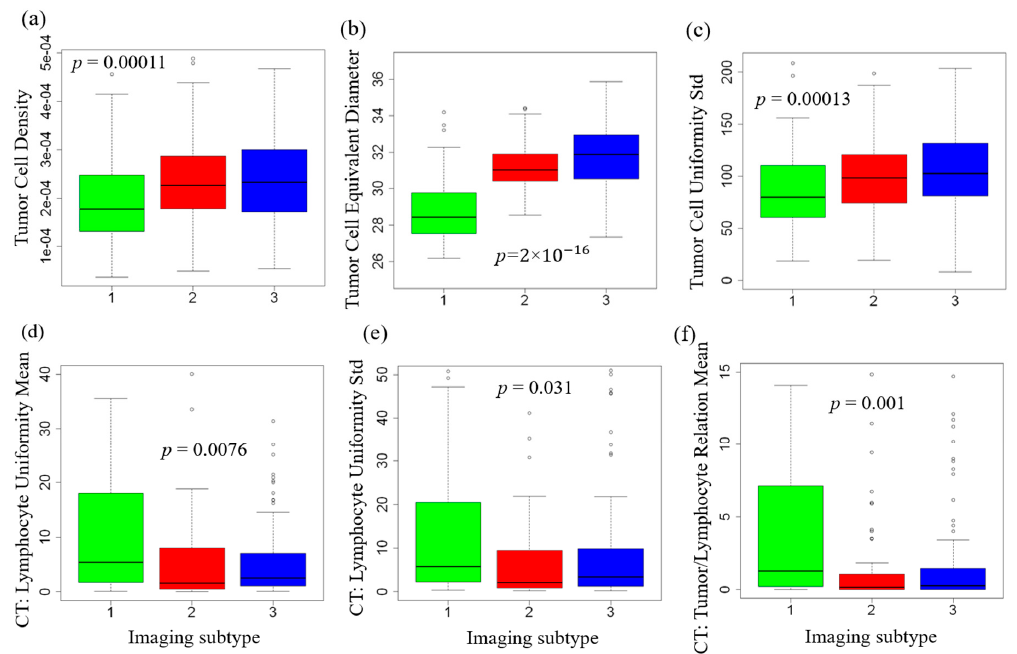
Figure 4. Selected quantitative imaging features that are significantly associated with the three imaging subtypes. All p -values are corrected for multiple testing. CT: tumor core. ( a ) tumor nuclei density; ( b ) tumor nuclei equivalent diameter; ( c ) tumor nuclei uniformity standard deviation; ( d ) lymphocyte uniformity mean; ( e ) lymphocyte uniformity standard deviation; ( f ) tumor and lymphocyte relation mean. These features are explained in Supplemental Table S1.